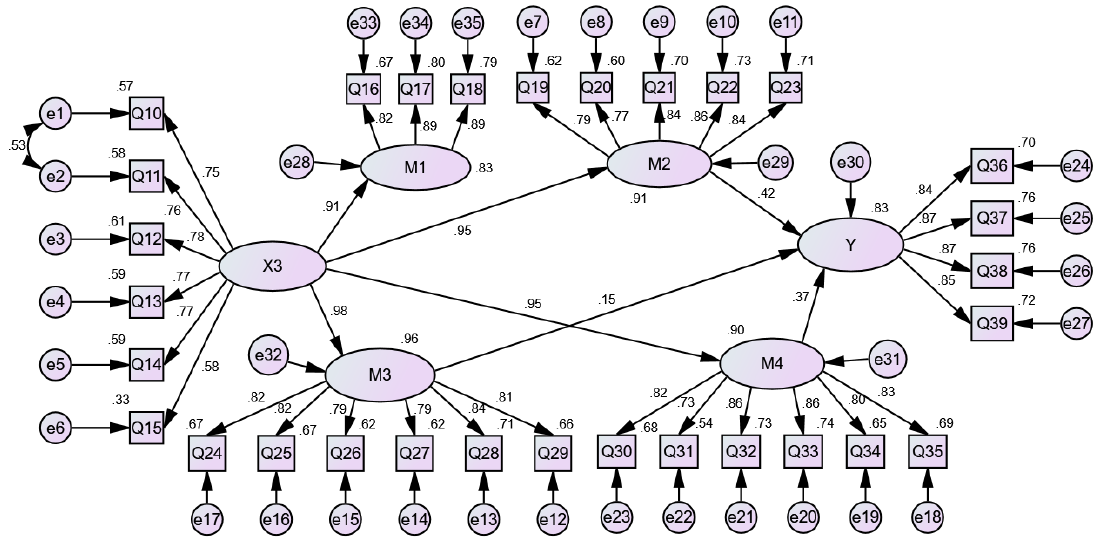
Figure 4. A revised model of the influence mechanism of social factors on the happiness of urban young returnees.